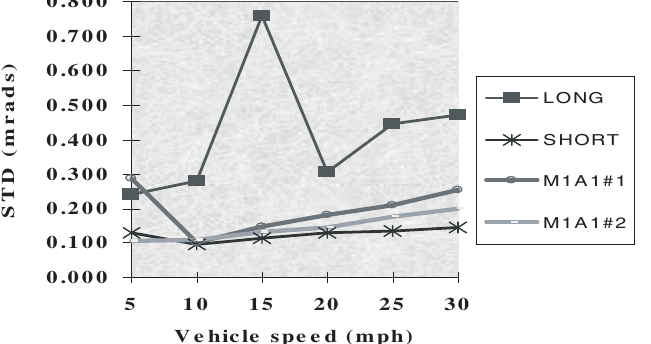
Fig. 8. CMRS azimuth average standard deviations.